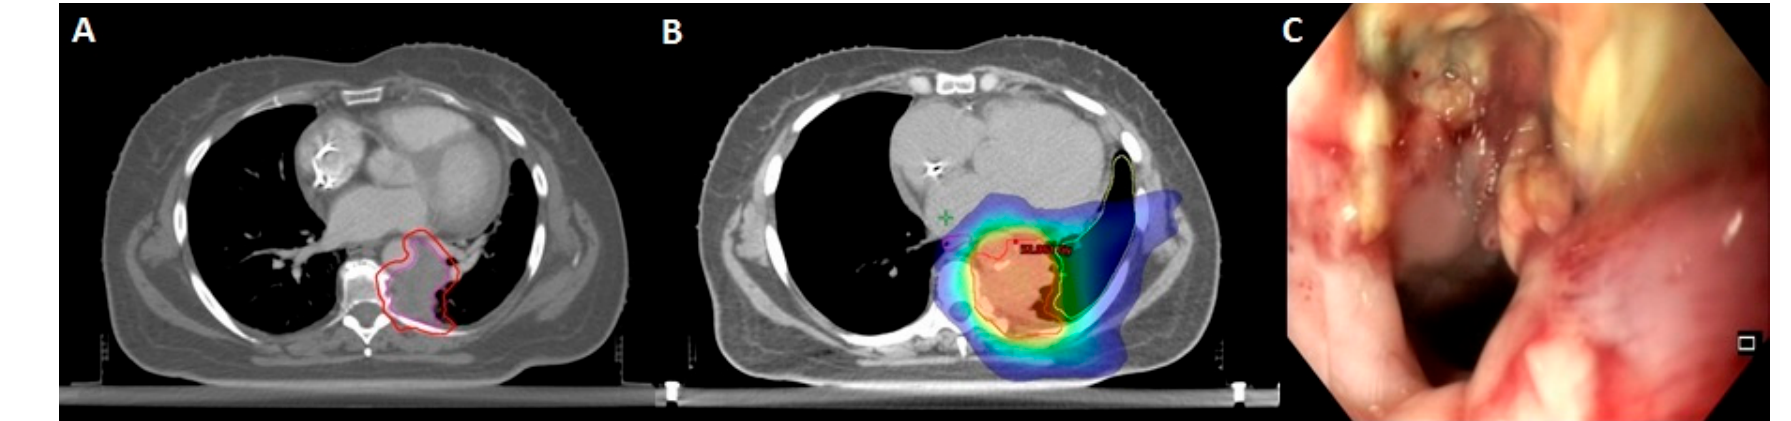
Figure 3. Patient with a clinical history of pT1aN0 lung adenocarcinoma treated with lingulectomy. A: Histologically-proven adenocarcinoma metastasis (34 mm) of the left paravertebral space, treated with SBRT (purple: GTV; red: PTV). B: SBRT delivering 50 Gy in five fractions to the PTV (dark blue: 20 Gy; light blue: 30 Gy; green: 40 Gy; yellow: 45 Gy; red: 50 Gy). C: Esophageal endoscopy following painful dysphagia and cachexia: extrinsic compression from tumor relapse associated to ulcerated mucosal ulceration possibly related to radiation treatment.